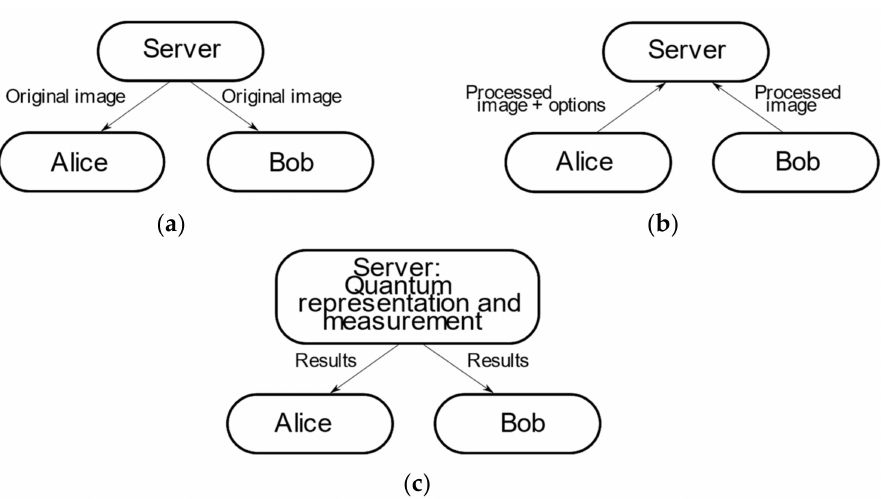
Figure 1. The proposed algorithm scheme can be summarized in 3 steps. ( a ) Step 1. The server sends an image to both parties. ( b ) Step 2. The parties process the image locally and send it back to the server (and Alice also sends some additional options, informing the server of the selected pixels and how they should be processed). ( c ) Step 3. The server processes the received images in a quantum manner, by taking into account the LSB of the indicated pixels (NEQR representation and measurement); the LSB values are used to create the quantum circuits and to apply the idea behind the B92 protocol to the qubit that corresponds to the LSB of the gray level for each pixel. After this, the server sends the results to both